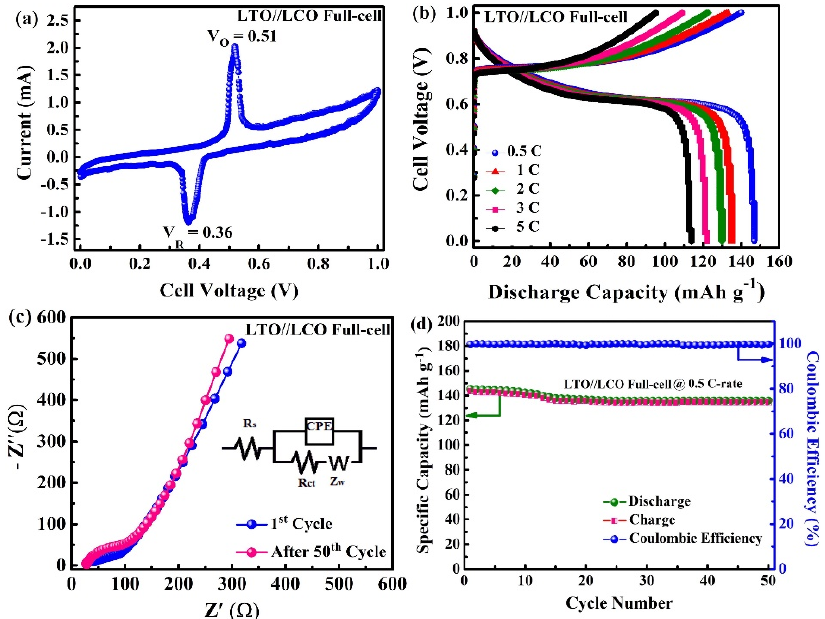
Figure 7. Electrochemical properties of a Li 2 TiO 3 //LiCoO 2 full cell with 1 mol L − 1 saturated Li 2 SO 4 aqueous solution as electrolyte and Ag/AgCl reference electrode. ( a ) Cyclic voltammetry curves. ( b ) Galvanostatic charge–discharge profiles carried out at various current rates from 0.5–5 C, ( c ) Electrochemical impedance spectrum. ( d ) Cycling performance at current rate of 0.5 C in the voltage range between 0.0 and 1.0 V. Table 1. Comparison of the electrochemical performance of various LCO-based aqueous cells. Number of cycles are given in parentheses. Averaged Specific Capacity Ref. Cell Electrolyte Cell Voltage (mAh g − 1 ) (V)